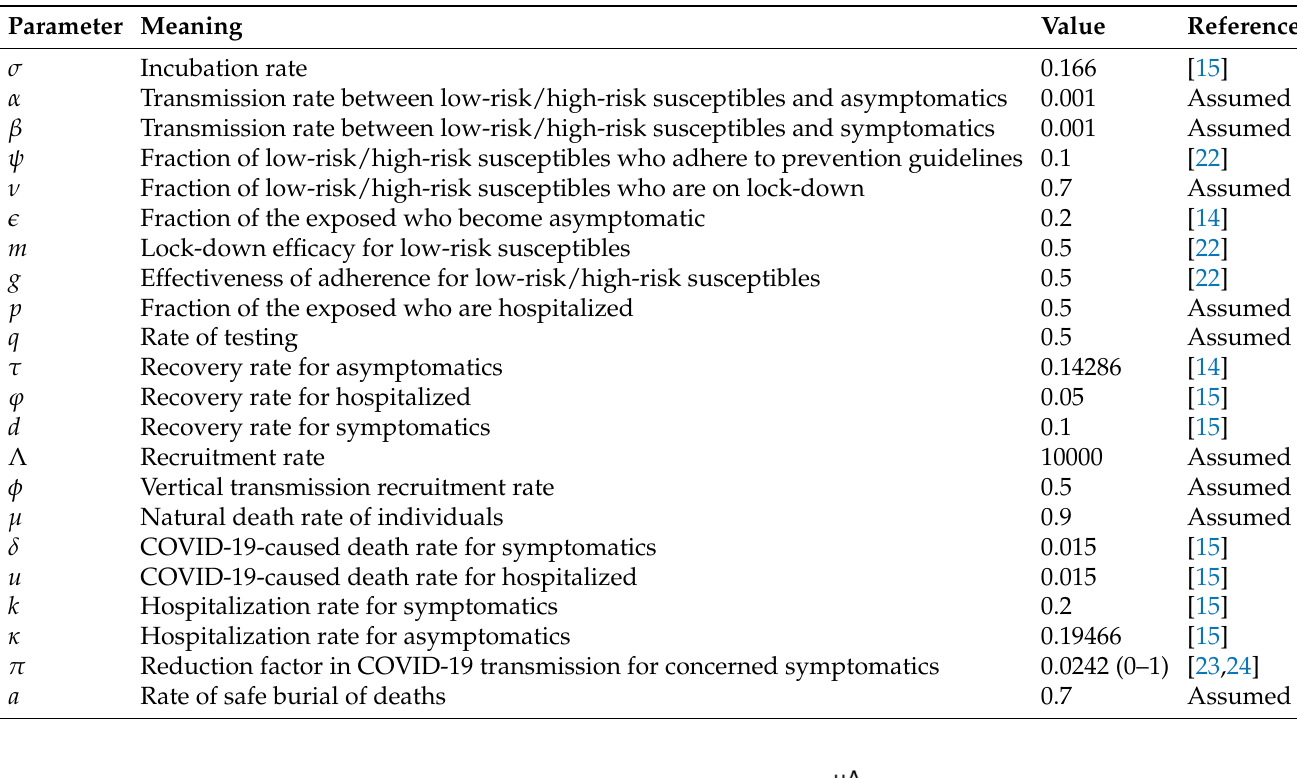
Table 2. Summary of the parameters.